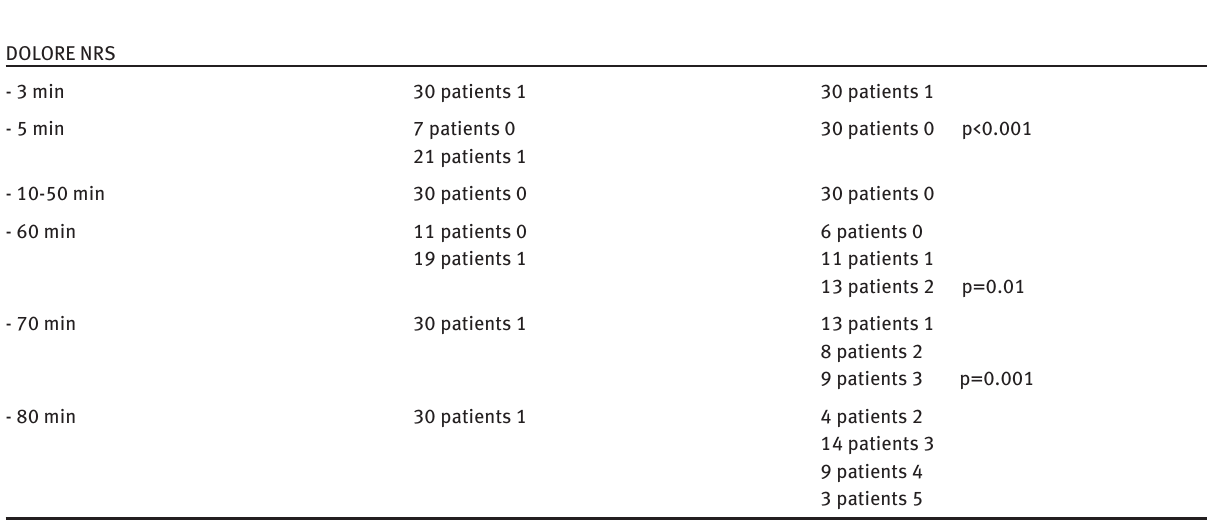
Table 2: Intraoperative pain relief assessment.